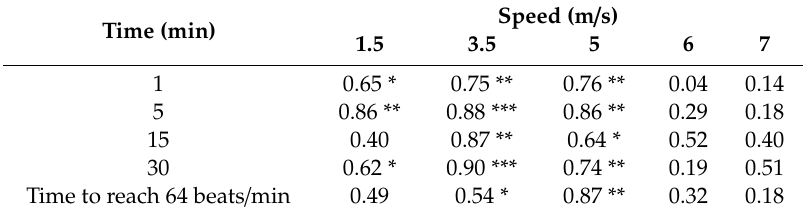
Table 5. Coe ffi cient of determination (r 2 ) and level of significance of the relationship between resting heart rate and recovery heart rate after 10 min of exercise at di ff erent speeds (seven horses). Time (min)